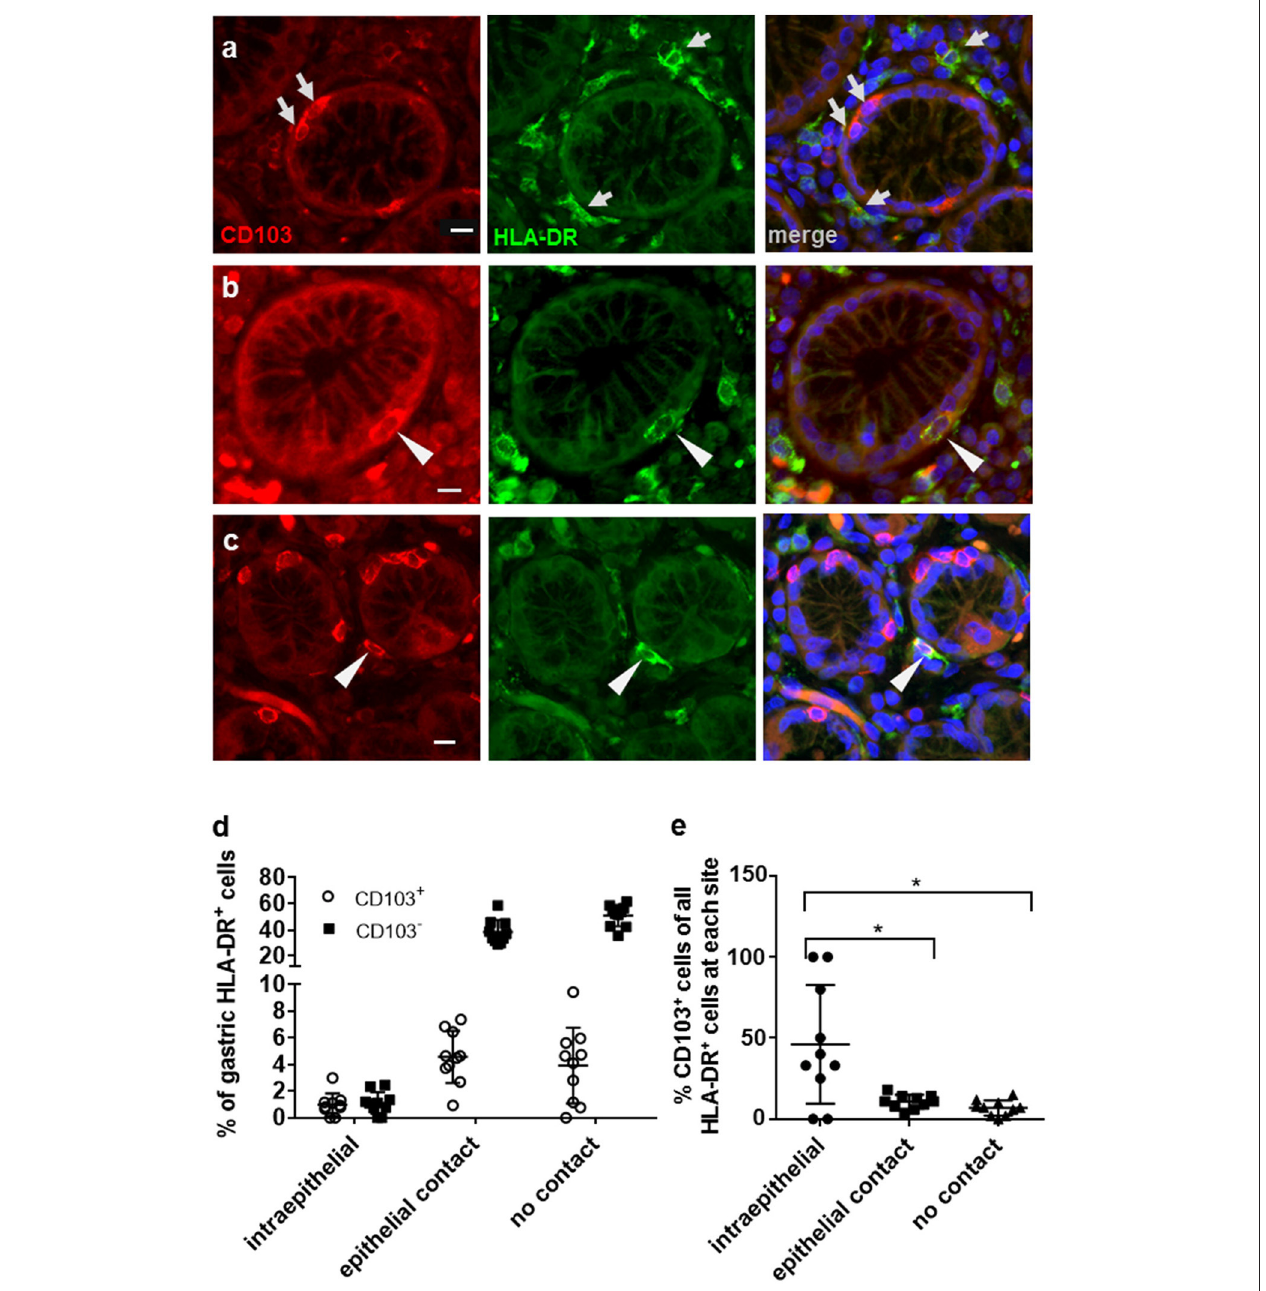
FIGURE 1 | Distribution of CD103 + DCs in human gastric mucosa. Paraffin-embedded tissue sections from the gastric mucosa of non- H. pylori -infected human subjects were immunofluorescently labeled for HLA-DR (Alexa 488, green) and CD103 (Alexa 555, red). Nuclei were stained with DAPI. (a) High magnification single color and merged images of gastric mucosa with multiple cells positive for either CD103 or HLA-DR (arrows). (b) Occasional intraepithelial HLA-DR + DCs and (c) subepithelial DCs with epithelial contact show staining for CD103. Arrowheads point out HLA-DR + DCs that co-express CD103. Bar = 20 µ m. (d,e) Quantitative analysis of HLA-DR + DCs with and without CD103 expression at intraepithelial, subepithelial (with epithelial contact), and lamina propria sites (no epithelial contact). Tissue sections from 10 human subjects were analyzed. * P ≤ 0.05, ANOVA with Tukey’s post-hoc test.